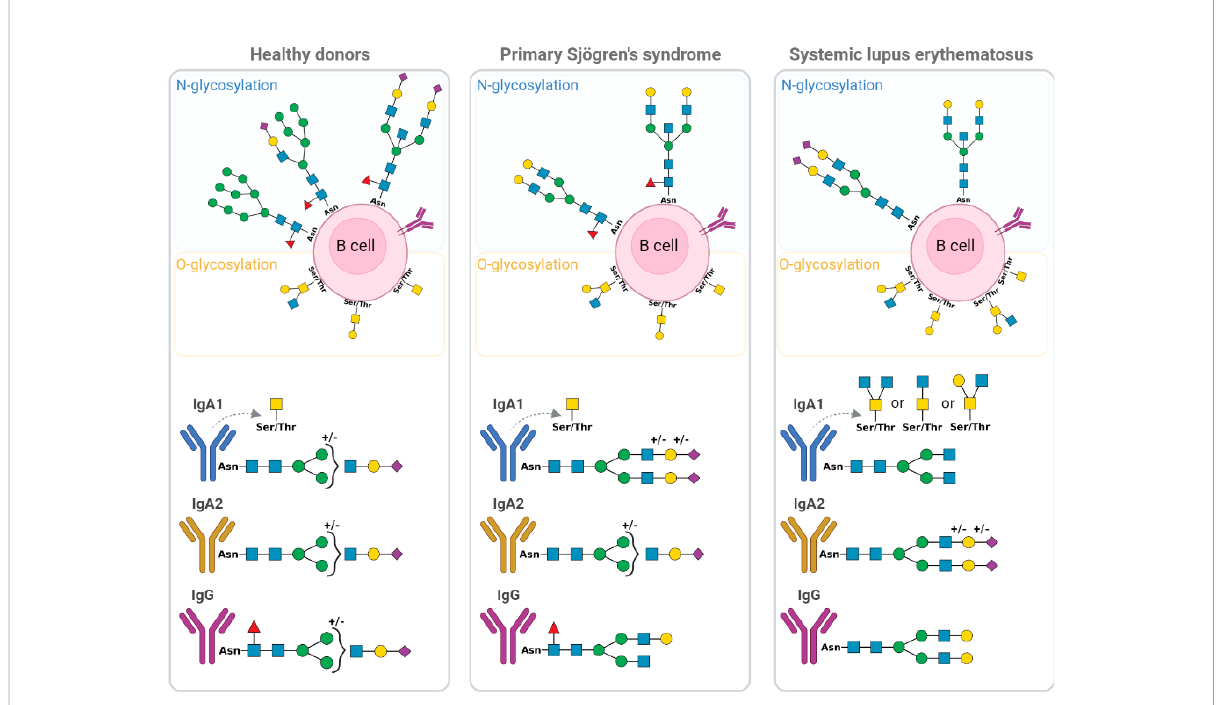
FIGURE 10 Schematic representation of glycosylation alteration of B cell and immunoglobulins IgA1, IgA2 and IgG from primary Sjögren ’ s syndrome (pSS) patients and systemic lupus erythematosus (SLE) patients compared to healthy donors (HD). The different forms of N and O-glycosylation on B cell surface are presented as well as IgA1, IgA2 and IgG glycan. Green circle: Mannose; yellow circle: Galactose; yellow square: N- acetylgalactosamine; blue square: N-acetylglucosamine; purple diamond; Sialic acid and red triangle; Fucose. Asn, Asparagine; Thr, Threonine; Ser,